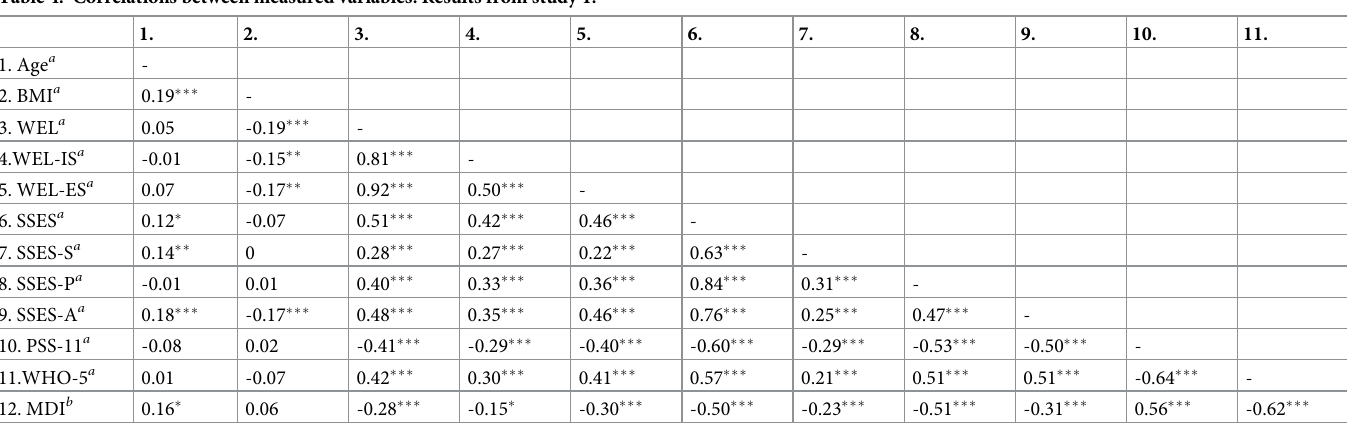
Table 4. Correlations between measured variables: Results from study